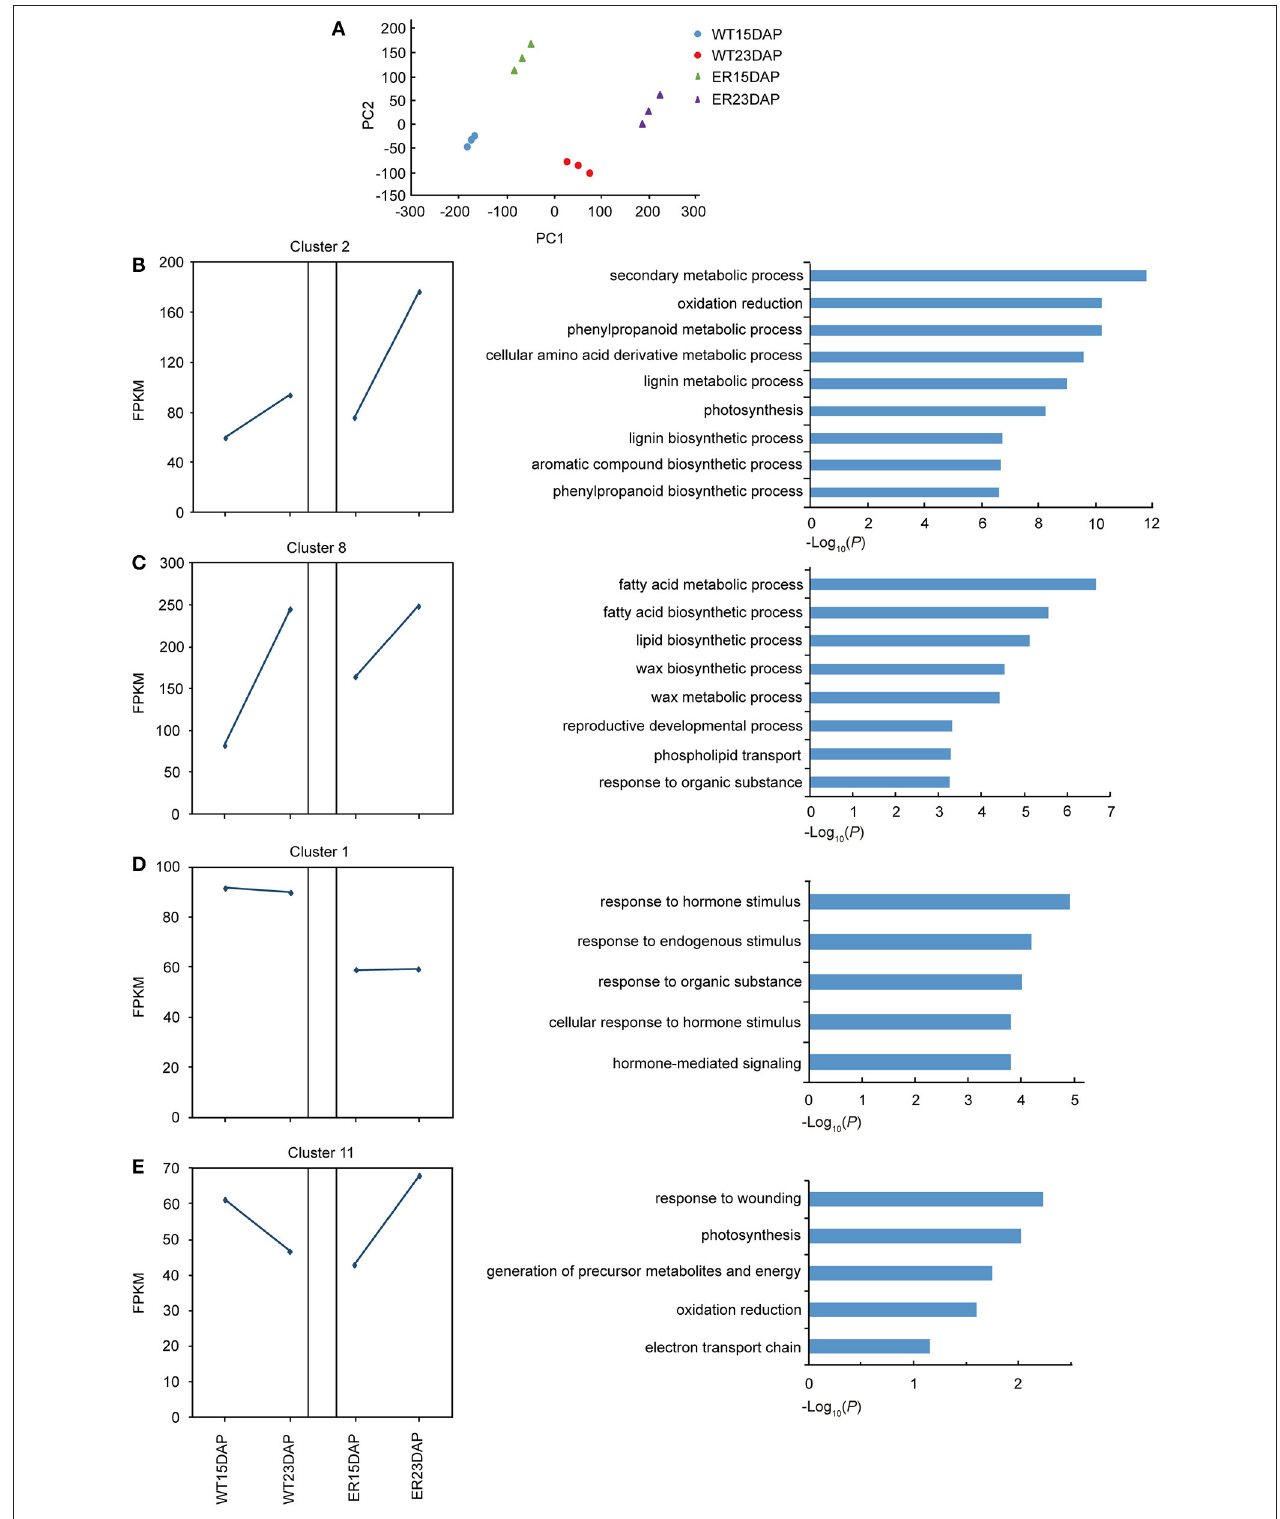
FIGURE 4 | Identification of differentially expressed genes (DEGs) between epidermal reticulation (ER) and WT fruit exocarp samples. (A) Principle component analysis (PCA) of the RNA-seq datasets. The triangles indicate the ER samples and the circles indicate the WT samples. Green and purple indicate samples from 15 days